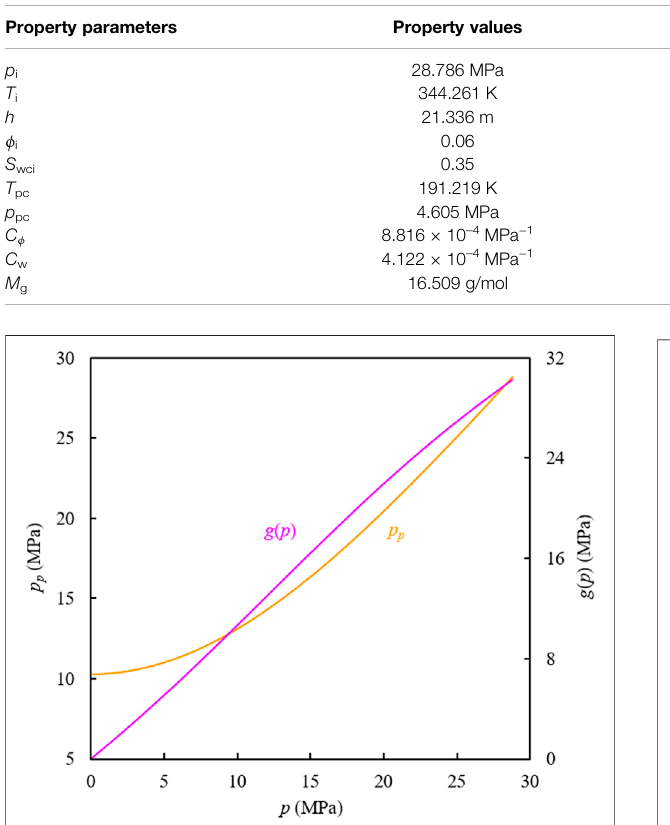
TABLE 2 | Reservoir and gas properties for the fi eld case.